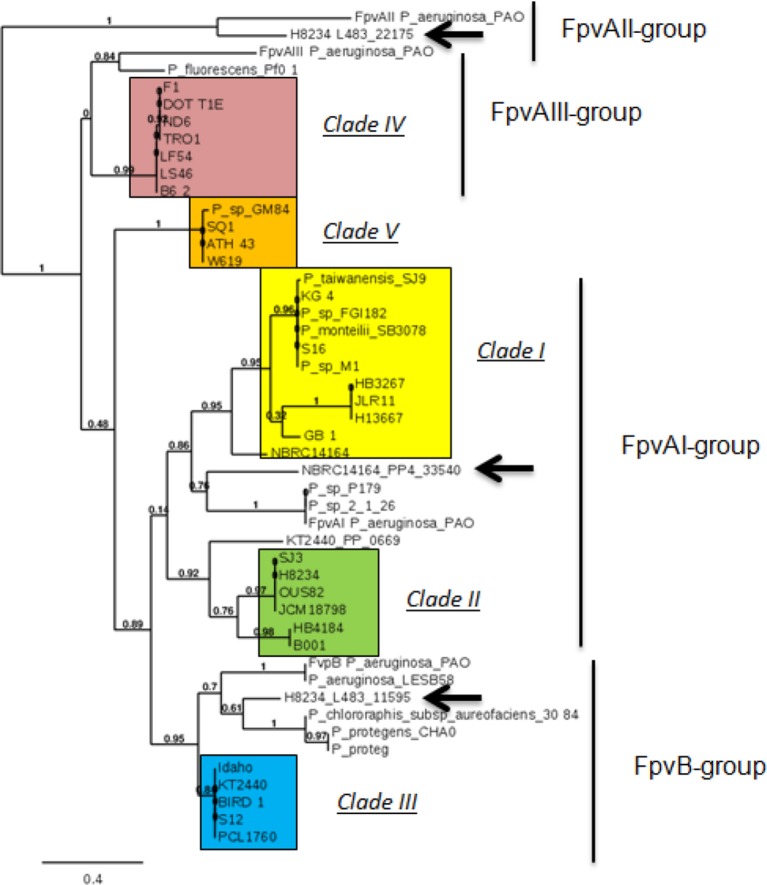
Phylogenetic three of the FpvA proteins from different Pseudomonas strains. Arrows represent exclusive TonB transporters from clinical strains. Clades are marked in the figure (square in yellow Clade I strains, in green Clade II strains, in blue Clade III strains, in red Clade IV strains, and in orange Clade V strains. Arrows indicate other TonB-dependent receptors from the studied strains that phylogenetically belong to the FpvA group. Software used to generate figure was Phylogeny.fr.